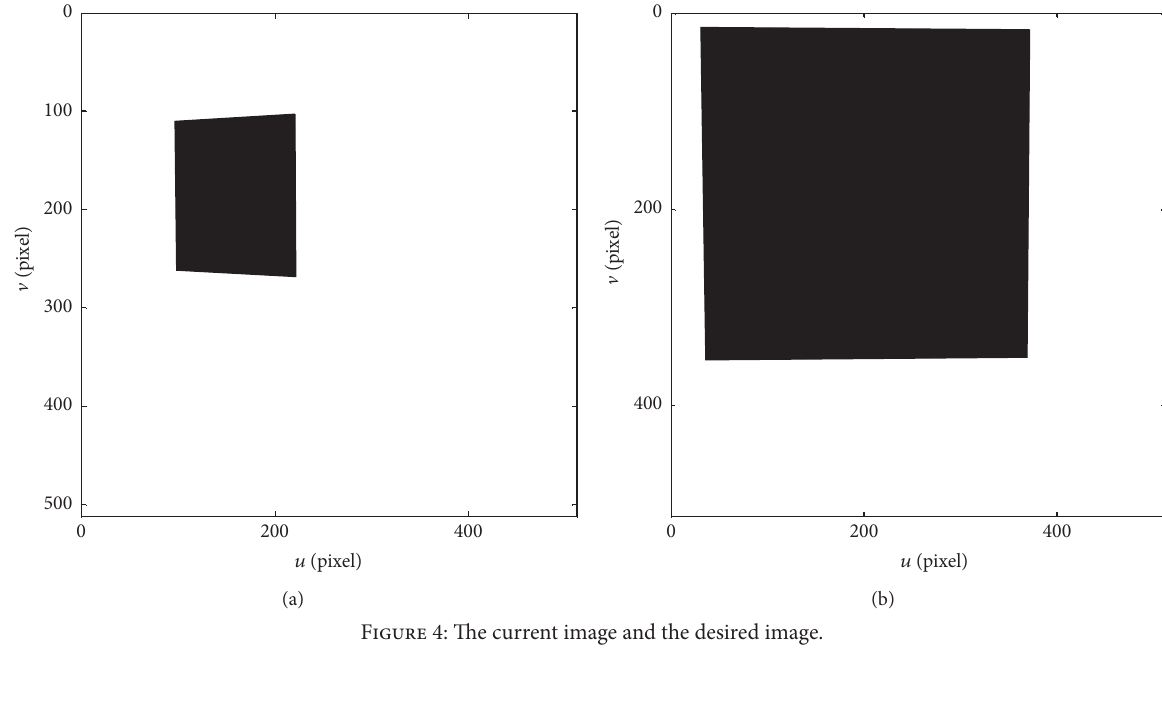
Figure 4: The current image and the desired image.